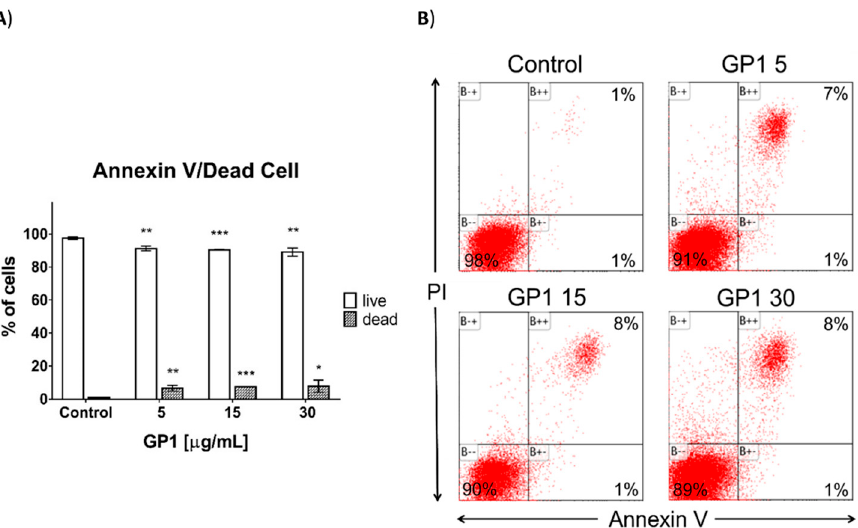
Figure 4. Viability analysis of A549 cells after eight-week treatment with GP1 in concentrations 5, 15, and 30 µg/mL using Annexin V/Dead Cell Apoptosis kit performed by flow cytometry. ( A ) Per- centage of live and dead cells in control and GP1-treated cells (mean ± SD, n = 3). ( B ) Representative plots of one of the three experiments. Statistical significance was evaluated with Student’s t -test. Significant differences from control * p < 0.0332 ** p < 0.0021 *** p < 0.0002.